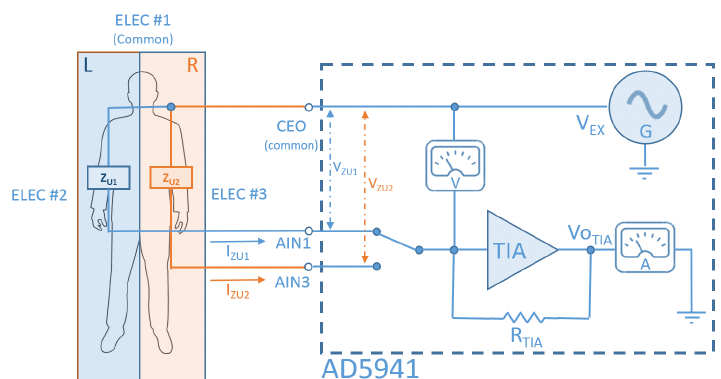
Figure 9. Block diagram for the measurement system. Observe the 3-electrode multiplexed configu- ration (see